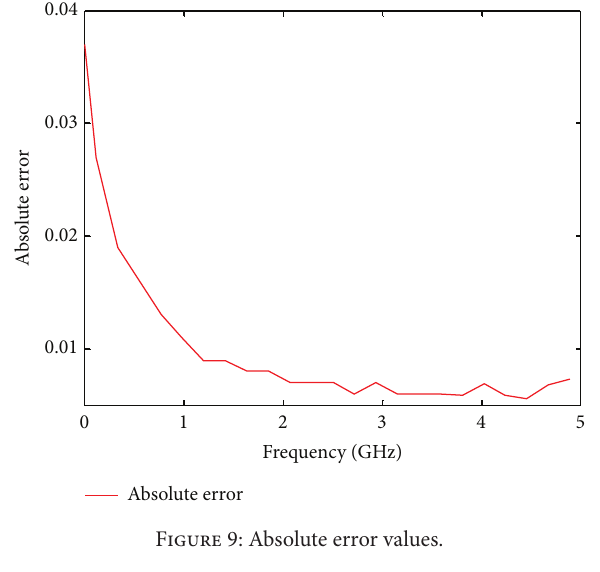
Figure 9: Absolute error values.